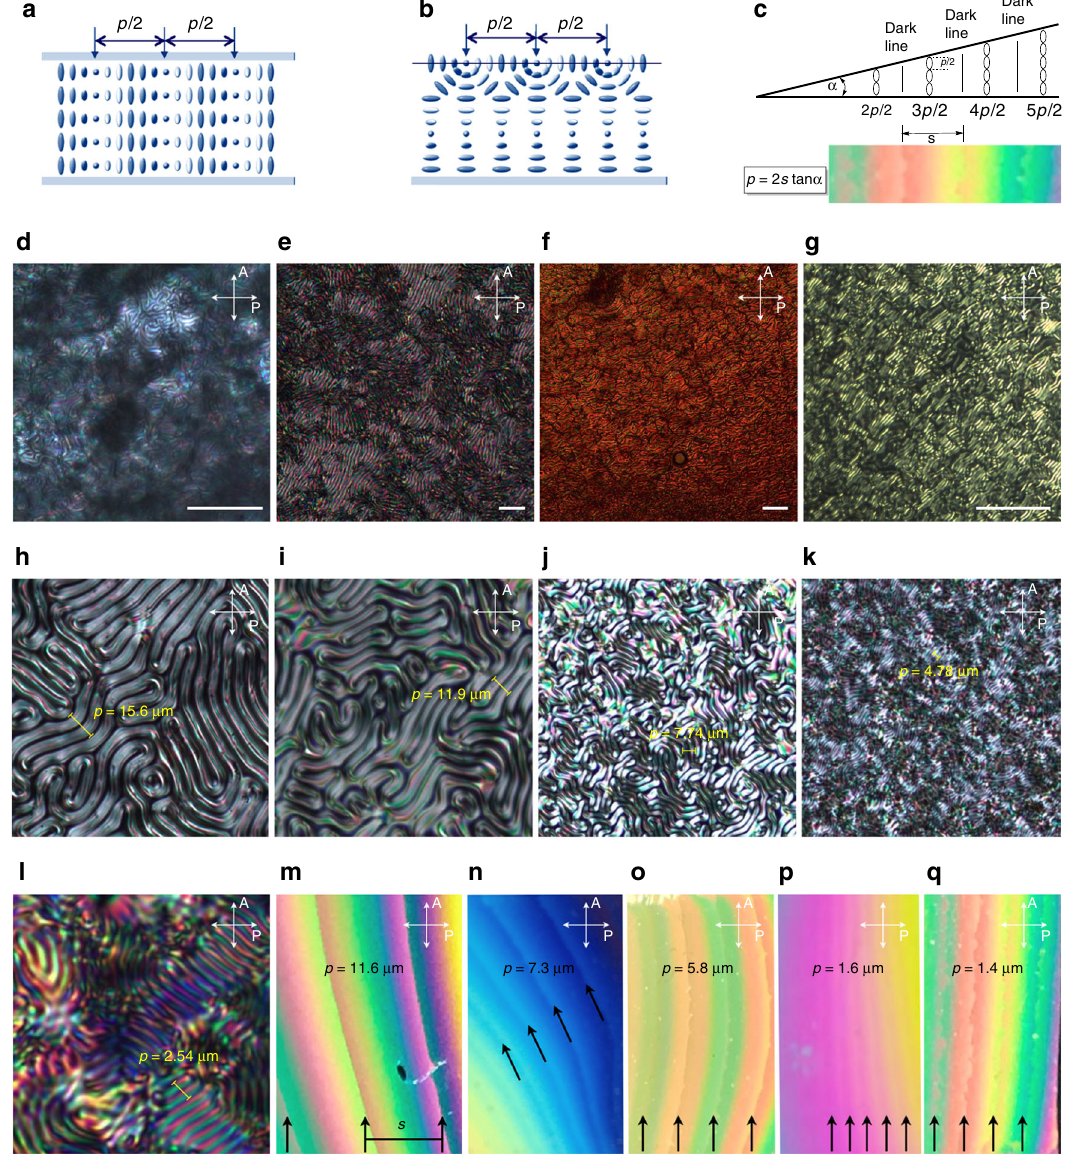
Fig. 3 Helical pitch measurements. a Representation showing the orientation of the helical axis parallel to the substrate in cells treated to favor homeotropic anchoring. The half-pitch p /2 is measured as the distance between two dark extinction lines by POM. b Representation showing the spatially varying director orientation at free surfaces (bottom substrate: plain glass; top substrate: air). The determination of p /2 is identical. c Drawing schematically depicting a Cano wedge cell and an example of an N*-LC- fi lled wedge cell with Grandjean Cano defect lines (steps) used to measure and calculate p . For details see Supplementary Note 9. d – g POM photomicrographs (crossed polarizers) of homeotropic cells of 5CB doped with GNR1 at: ( d ) 0.1 wt.%, ( e ) 0.2 wt.%, ( f ) 0.3 wt.%, and ( g ) 0.5 wt.% (scale bars: 50 μ m). h – l POM photomicrographs (crossed polarizers) of free surface preparations of 5CB doped with GNR2 at: ( h ) 0.05 wt.%, ( i ) 0.1 wt.%, ( j ) 0.2 wt.%, ( k ) 0.3 wt.%, and ( l ), 0.5 wt.%. m – q POM photomicrographs (crossed polarizers) of Cano wedge cells (with the glass surfaces modi fi ed to induce planar anchoring) of 5CB doped with GNR1 at: ( m ) 0.1 wt.%, ( n ) 0.2 wt.%, ( o ) 0.3 wt.%, ( p ) 0.4 wt.%, and ( q ) 0.5 wt.% (for more details on POM image analysis and determination of p , see Supplementary Note 9, Supplementary Figs. 15 –